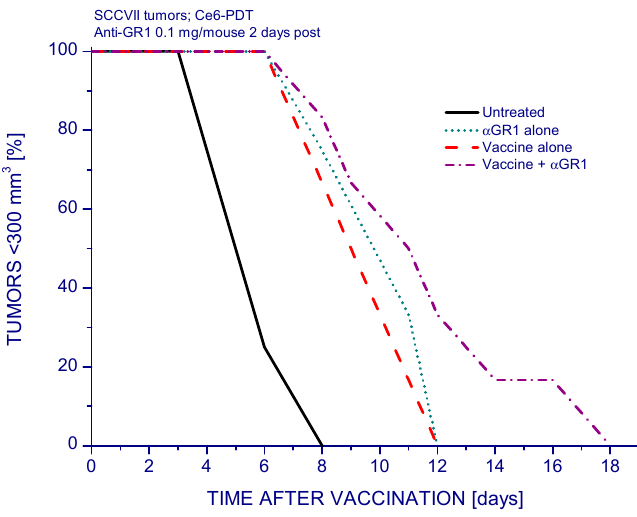
Figure 3. The effect of anti-GR1 treatment on the response of SCCVII tumors to PDT vaccine. Two days after peritumoral administration of PDT vaccine (prepared as described for Figure 2), the mice were injected with anti-GR1 (0.1 mg/mouse i.v.) or control saline. Control groups include mice treated with anti-GR1 alone. The response to therapy was evaluated by tumor size measurement and is presented as percentages of mice with tumors smaller than 300 mm 3 in function of time after vaccination. Each treatment group consisted of 6 mice. Statistically significant ( p < 0.05) were the differences between the control untreated group response and all the three treated group responses.